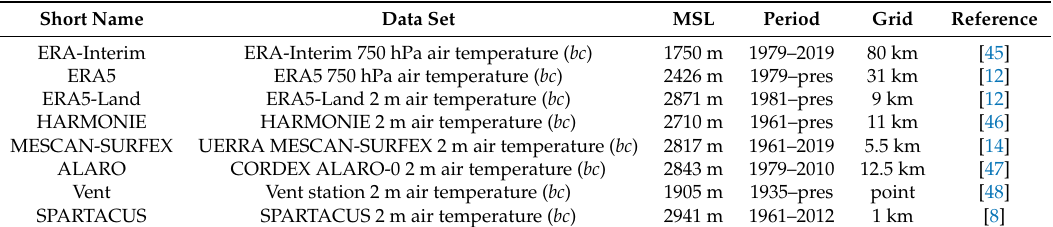
Table 1. Short names and details for the reference data sets considered in this study. All reference data sets were bias corrected based on obs-training (bc); see Equation (3). The altitude (MSL) refers to the height of the surface topography for the coordinates corresponding to VERNAGT.